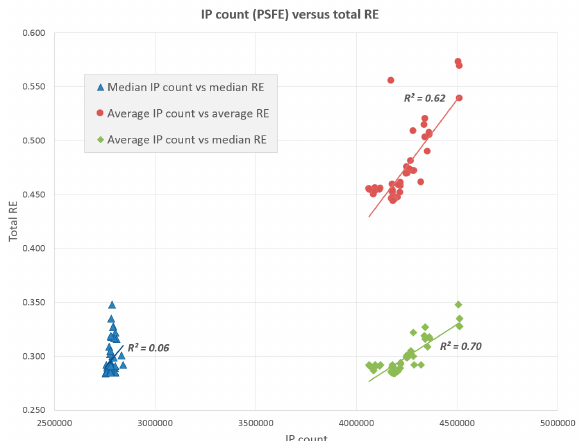
Figure 4. Total IP count (PSFE) versus total RE, averaged over all image collections.